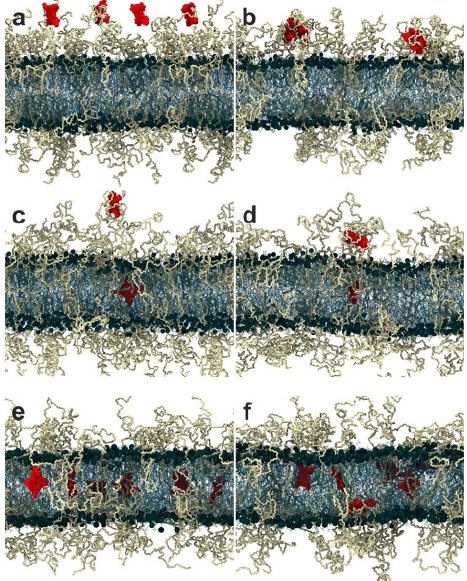
Figure 6. Snapshots of simulations showing the penetration of hydrophobic porphyrins into the PEGylated lipid bilayer as a function of time: four porphyrins at 0 ns ( a ) and 100 ns ( b ); two porphyrins at 0 ns ( c ) and 350 ns ( d ); six porphyrins at 0 ns ( e ) and 350 ns ( f ) (reprinted with permission from [154]. Copyright (2015) American Chemical Society).